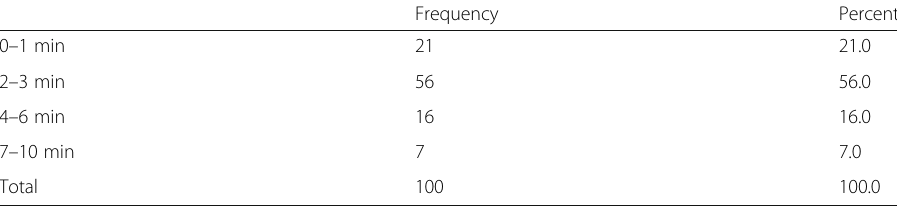
Table 4 Time Taken to Process the Working Data